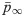
Long-term value p¯∞ of the fraction of cooperators versus the cost-to-benefit ratio ρ in the donation game on empirical networks.(a) Γhepth. (b) Γastro. (c) Γfb. (d) Γinternet. The dashed lines show the critical values of the cost-to-benefit ratio ρc=1k-1.